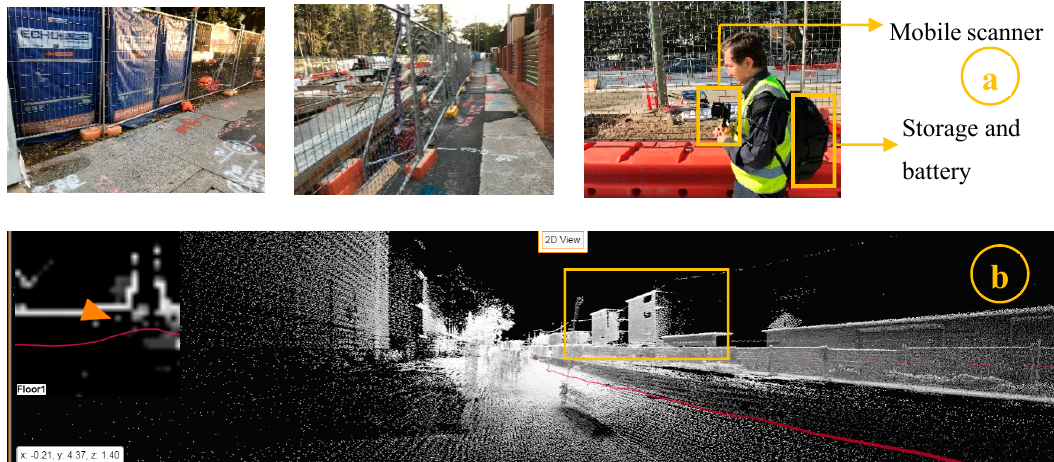
Figure 2. Infrastructure construction survey using a Geo SLAM (Simultaneous Localisation And Mapping) hand-held scanner: ( a ) data acquisition from a light rail project in Randwick, Sydney; ( b ) illustration of tracing route in red.